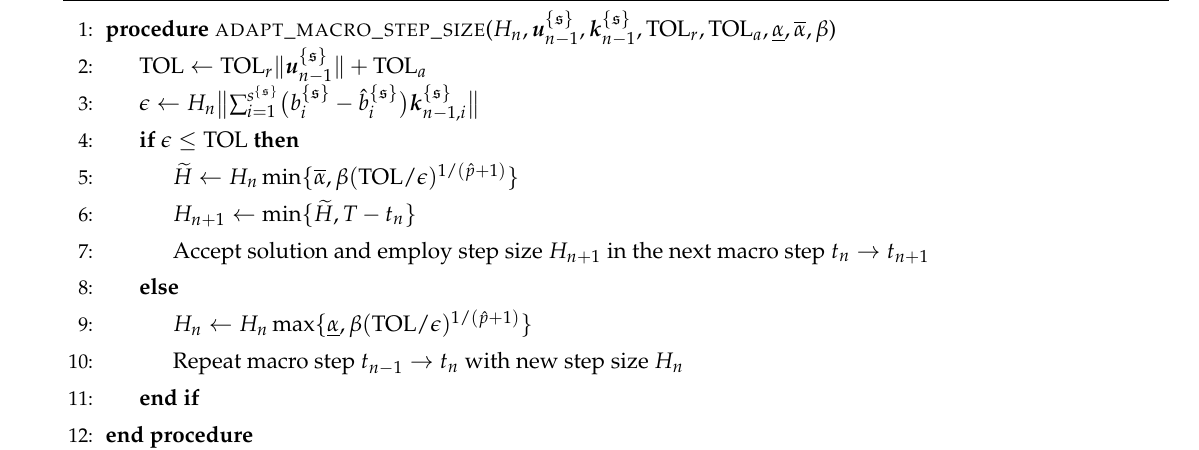
Algorithm 3 Adaptive step size determination for macro step t n